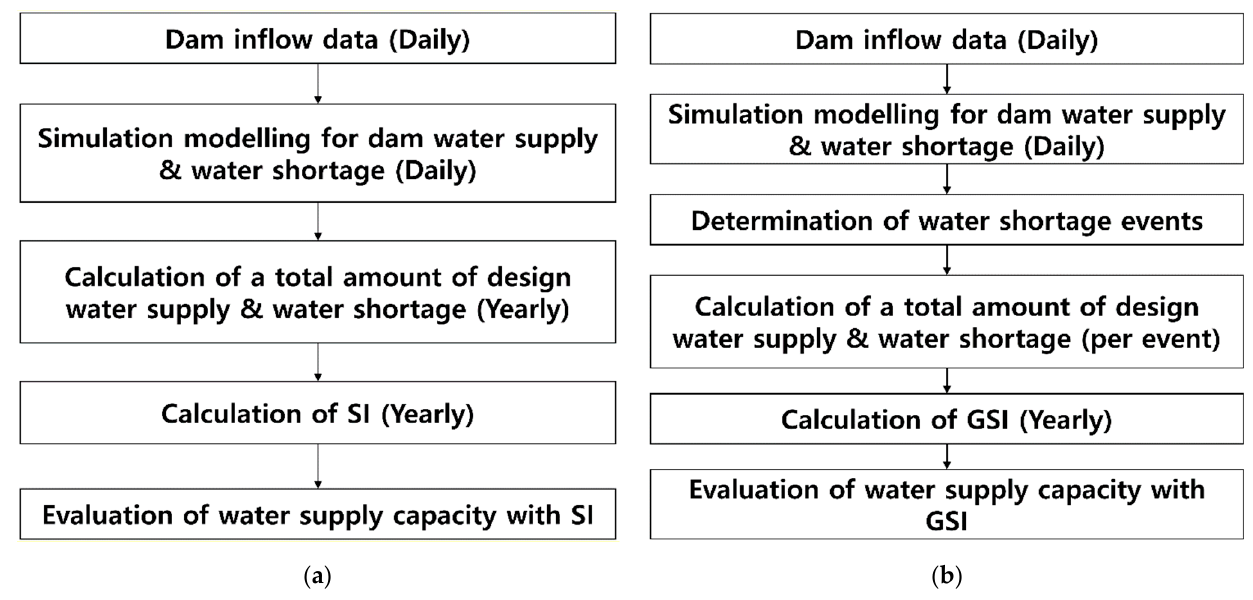
Figure 1. Application procedure of water-shortage index used in this study: ( a ) SI ; ( b ) GSI.